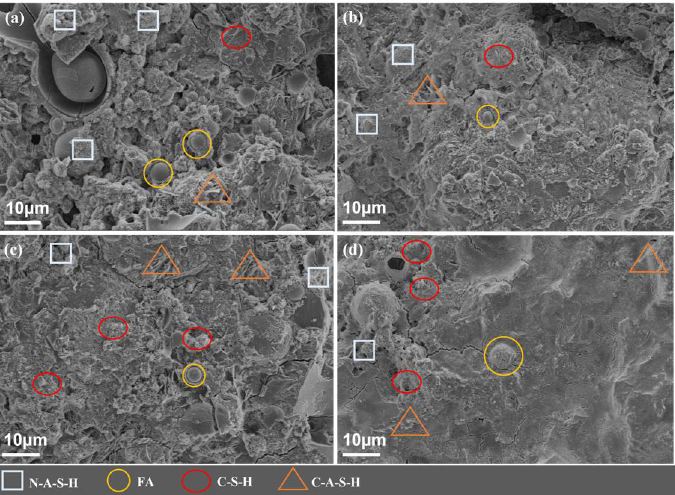
Figure 22. SEM morphology of the geopolymer slurry with different slag content (28d, NaOH: 4%, Na 2 SiO 3 : 5%). ( a ) Slag content: 20%; ( b ) Slag content: 30%; ( c ) Slag content: 40%; ( d ) Slag content: 50%.